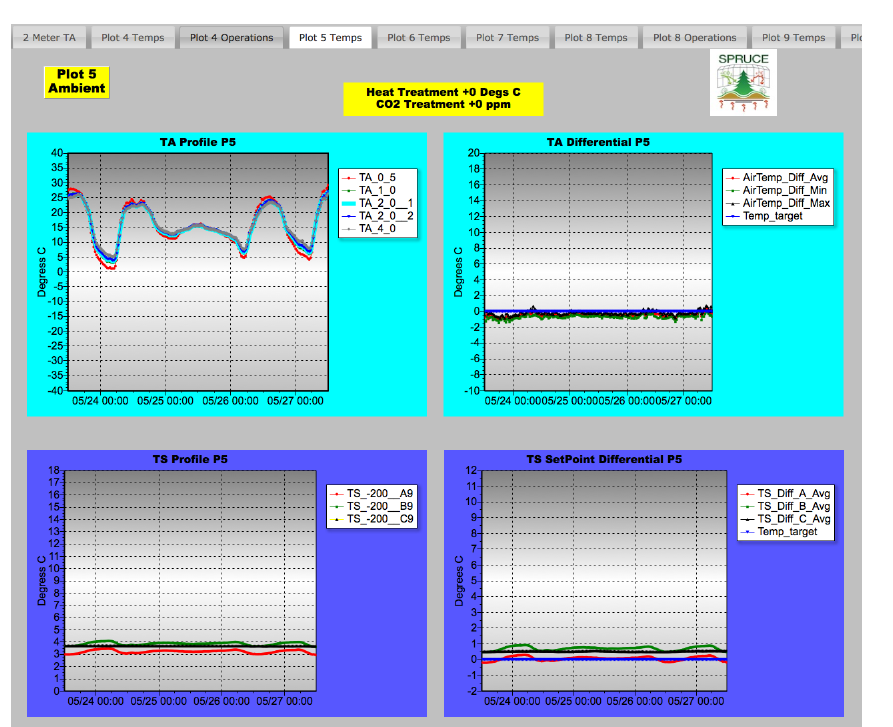
Figure 6. RTMC monitoring